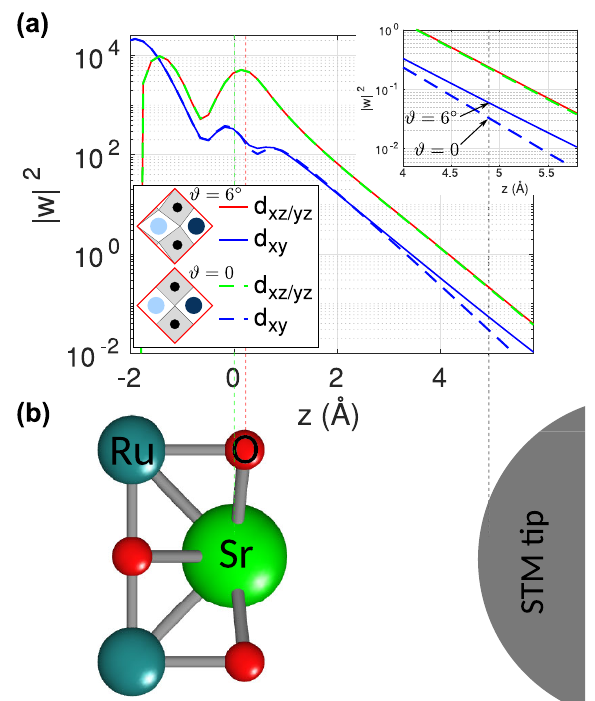
Fig. 3 Tunneling probabilities at different tip-sample distances. a Partial norm of the Wannier functions at fi xed height z showing the large values close to the atoms and the exponential decay in the vacuum. Although the O-octahedron rotation has negligible in fl uence on the norm of the Wannier orbitals associated with the d xz / yz bands, it enhances the value of the Wannier orbital associated with the γ band, which has predominantly d xy character, signi fi - cantly, and also increases the decay length in j W j 2 / exp ð(cid:2) z = α Þ from α xy = 1.9 Å to α xy = 2.2 Å . b Surface geometry of Sr 2 RuO 4 with the Ru and O atoms on the surface at z ≈ 0 (green and red dotted lines for these planes) and the STM tip ~5 Å above (black dashed